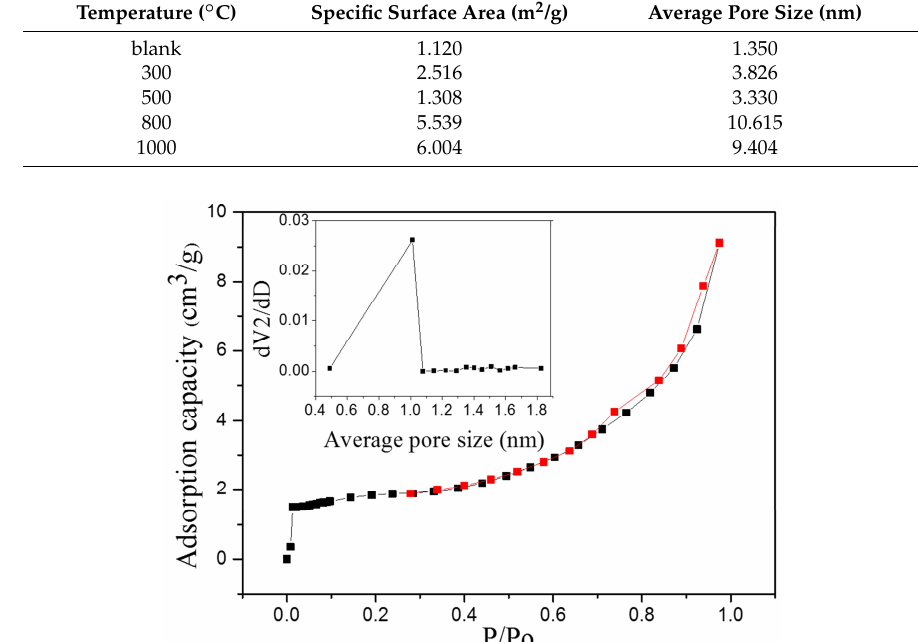
Specific surface area and average pore size of as-prepared samples at different puffing temperature.